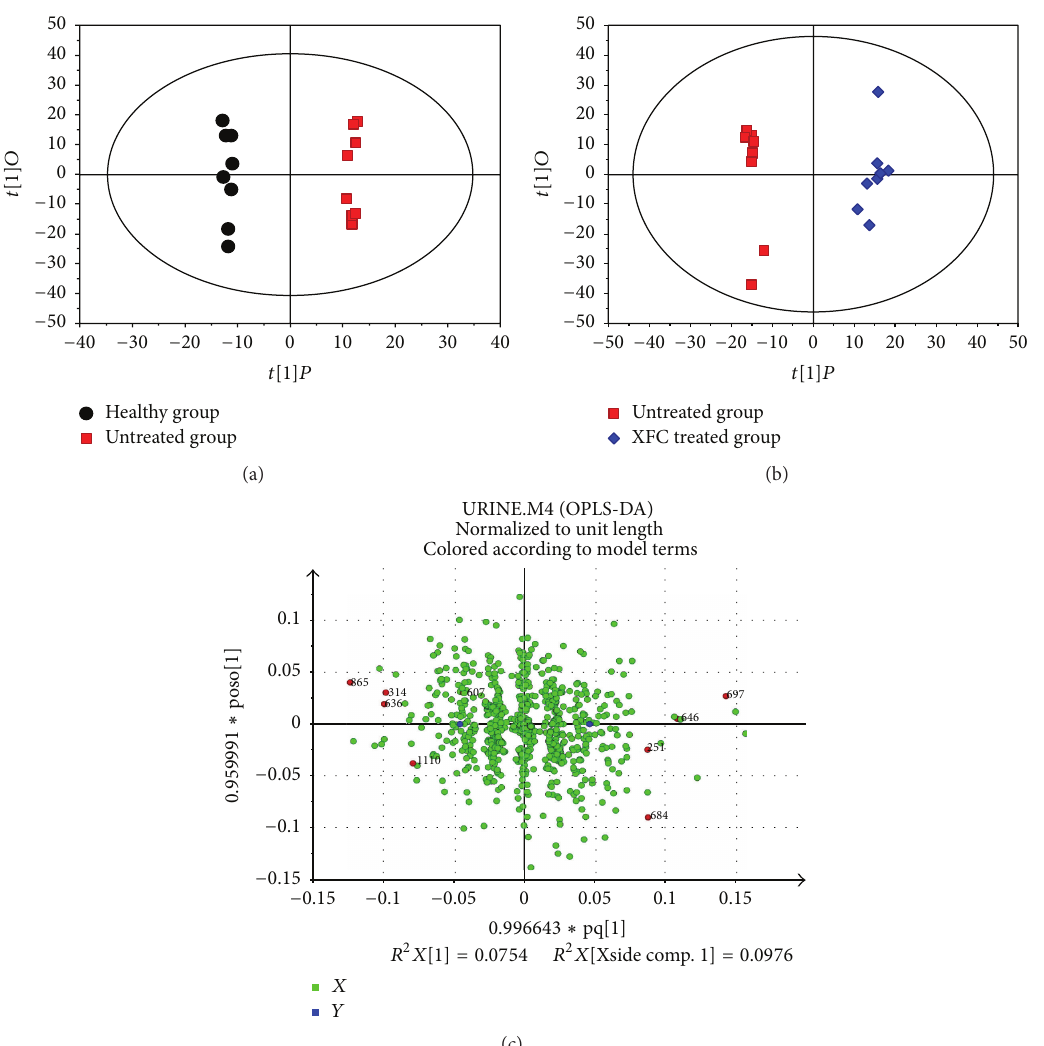
Figure 6: OPLS-DA of urine metabolic profiling of healthy group versus untreated group (a); OPLS-DA of urine metabolic profiling of untreated group versus XFC treated group (b); OPLS-DA variable loading plot